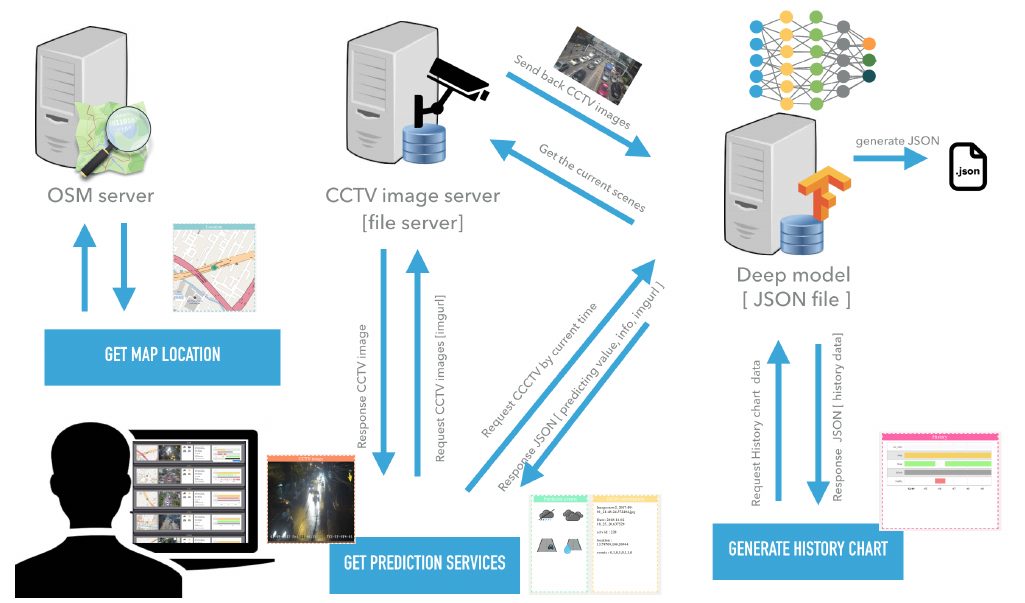
Figure 5. Overall system